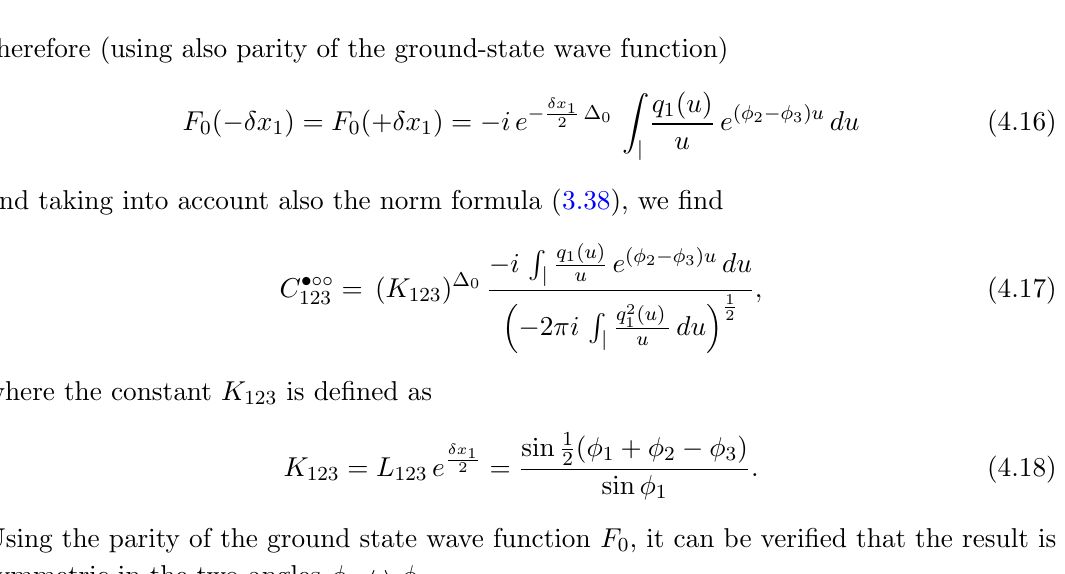
Figure 9 . The HHL correlator. In this case there are two types of propagators since two couplings are